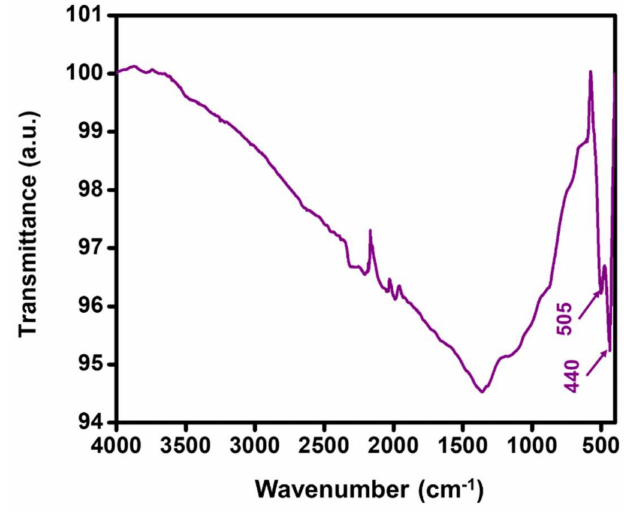
Figure 3. FT-IR spectrum of the as-prepared ZnO nanocrystals.